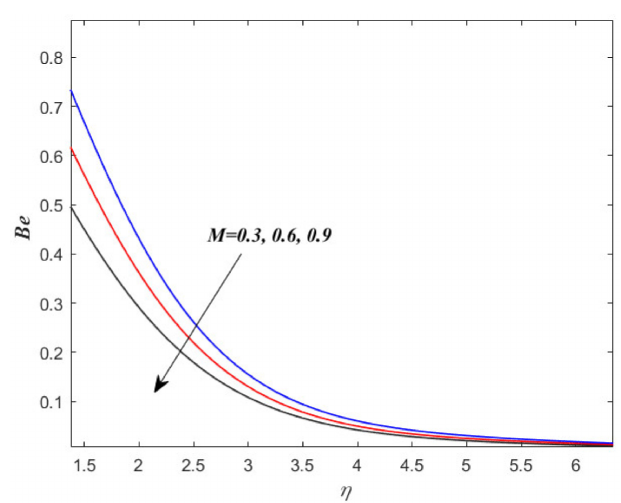
Figure 10. Various values of radiation parameter ( R ) on N G .